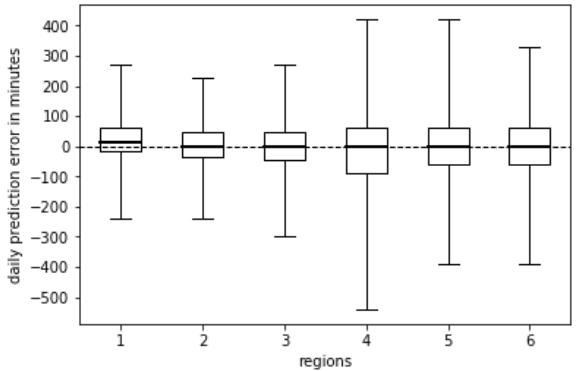
Figure 3. Residual distribution of the NOC approach for each region.